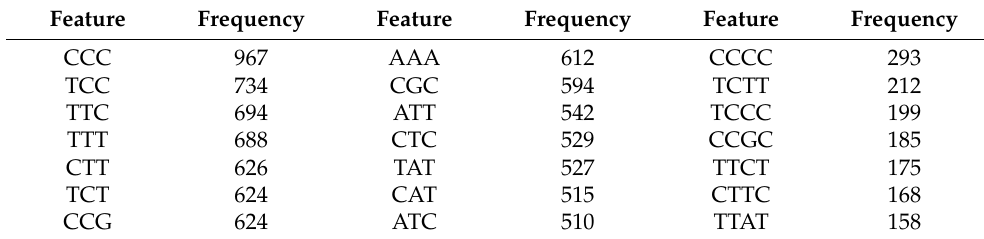
Table 10. The statistics of promoter feature occurrence frequency in